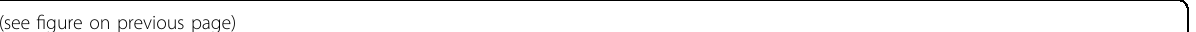
Fig. 8 Myc -dependent early phase microglia proliferation is not suf fi cient to induce late-phase microglia proliferation. a , b Ki67 fl ow- cytometry scatter plots ( a ) and the associated quanti fi cation ( b ). Ki67 ( + ) proliferating microglia increased transiently in the spinal cord of Cx3cr1- creER-yfp/ + ; + / + animals 2 days after LPS treatment. c qRT-PCR of sorted lumbar cord microglia from Cx3cr1-creER-yfp/ + ; + / + animals. Myc was transiently upregulated in microglia 4 h after LPS treatment, and the expression returned to baseline level by 1 day. d Quanti fi cation of Ki67 fl ow cytometry. Myc deletion in adult microglia abolished the LPS-induced lumbar cord microglia proliferation. e , f Representative Ki67 IHC images ( e ) and the associated quanti fi cation ( f ). Animals with Myc deletion from adult microglia had signi fi cantly less Ki67 ( + ) proliferating microglia in lumbar dorsal cord (DC) 2 days after LPS. The arrowheads point to the Ki67 ( + ) microglia, and the dashed lines outline the dorsal lumbar cord. Microglia are identi fi ed by YFP staining. g qRT-PCR of sorted lumbar cord microglia from Cx3cr1-creER-yfp/ + ; + / + animals. Tnfaip3 was transiently upregulated in lumbar cord microglia 4 h after LPS treatment, and the expression returned to baseline level by 1 day, without any Tnfaip3 downregulation. Analyses are one-way ANOVA with Tukey ’ s multiple-comparison test ( b , c , g ) or two-way ANOVA with Sidak ’ s multiple-comparison test ( f ), and unpaired two- tailed t -test ( d ), n = 4 – 6, means ± SEM, * P < 0.05, ** P < 0.01, *** P < 0.001; ns, not signi fi